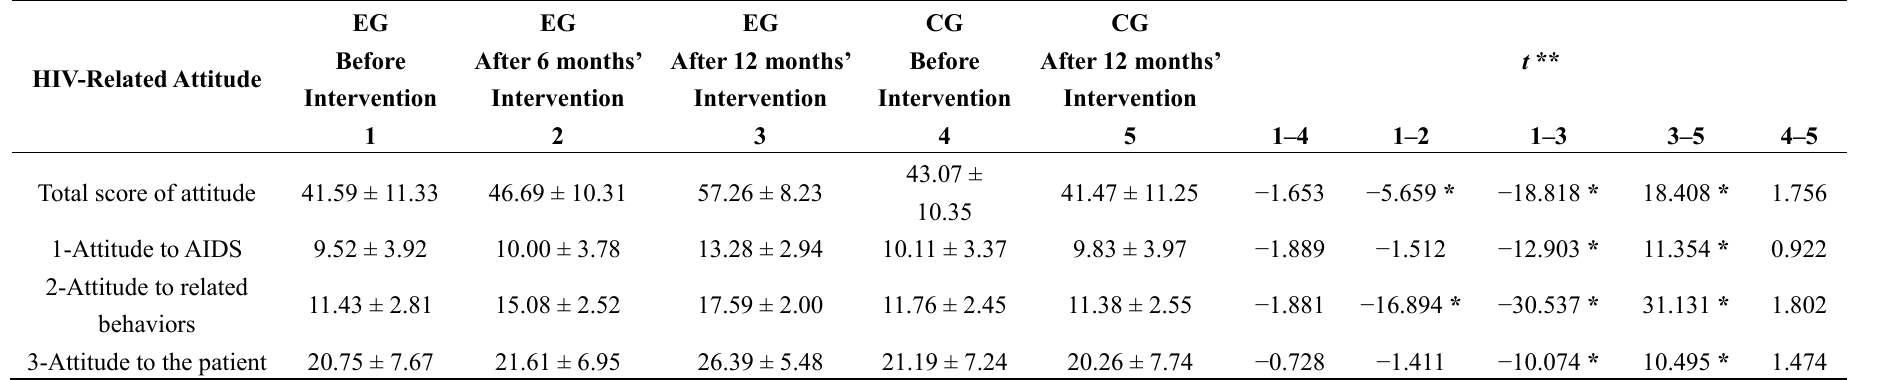
Table 3. Differences in HIV/AIDS attitude